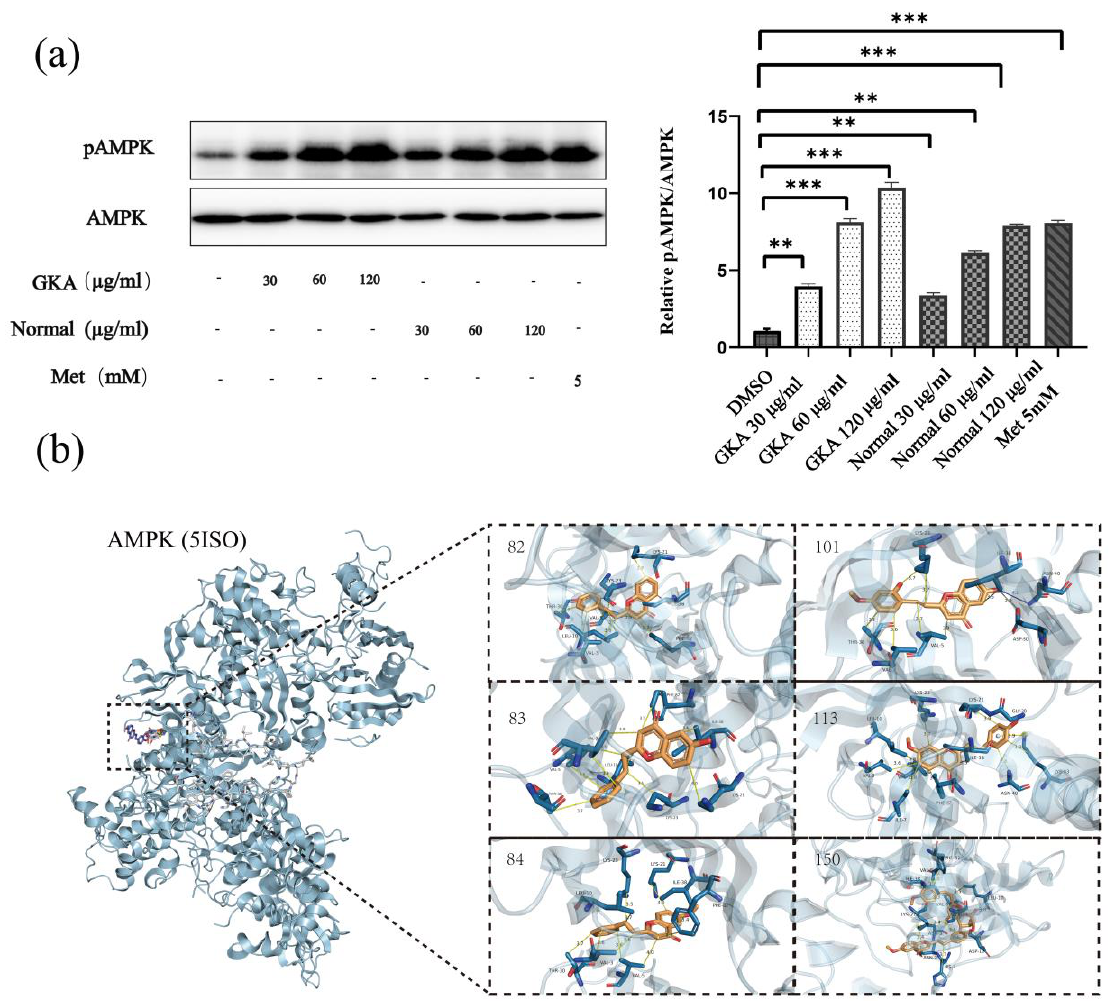
Figure 8. In vitro activity and validation study of the agarwood ethanol extracts activates AMPK in 293T cells. The cell lysates were subjected to SDS-PAGE and Western blot analysis using antibodies specific for phospho-AMPK or total AMPK. The results are presented relative to the vehicle control (DMSO) and as the mean ± SD ( n = 3). ** p < 0.01; *** p < 0.001 ( a ). The binding mode of some representative compounds with AMPK; the codes for the compounds in the figure correspond to those in Supplementary Materials Table S2 ( b